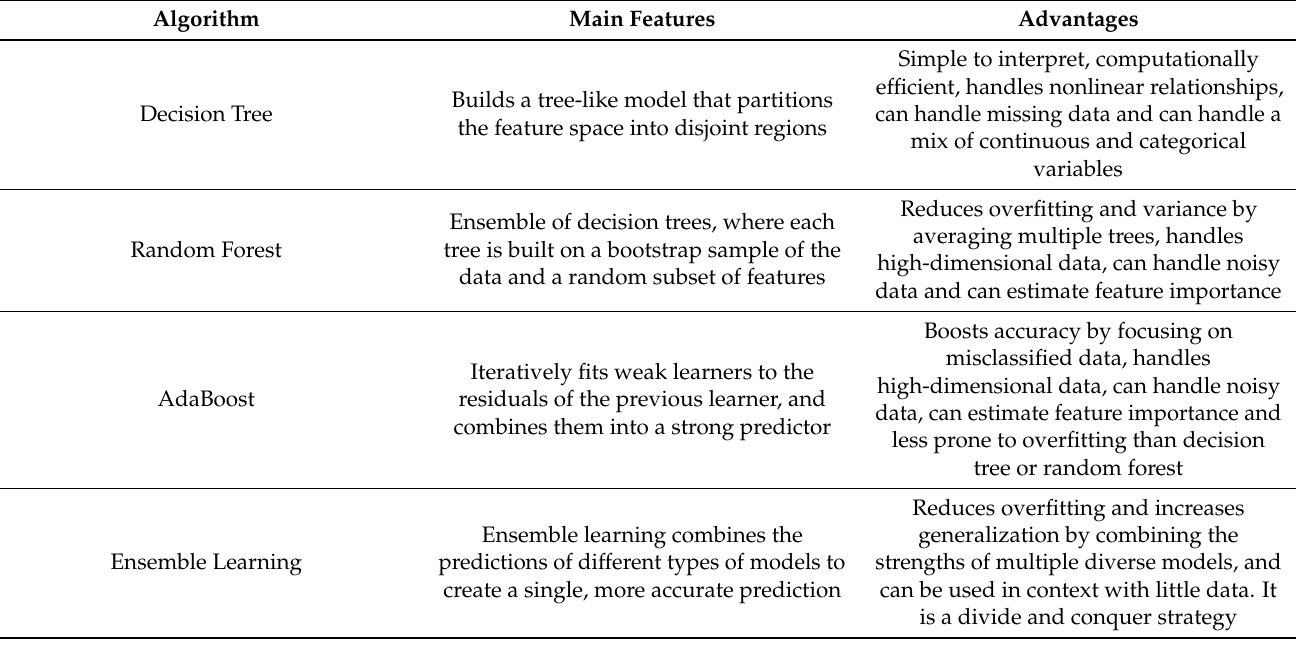
Table 5. Main features of the algorithms based on tree